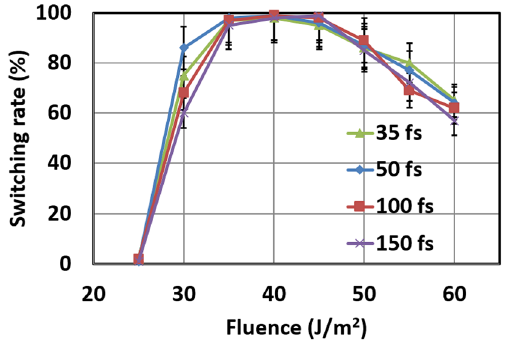
Figure 3. Switching rate of magnetization in synthetic antiferromagnet with bilayer FeGd as a function of laser fluence. Simulations at each fluence is repeated 128 times and the switching rate is the percentage of switching occurred out of 128 simulations. Error bars correspond to one standard deviation from avenging. 35 fs (green), 50 fs (blue), 100 fs (red) , and 150 fs (purple) shows similar switching